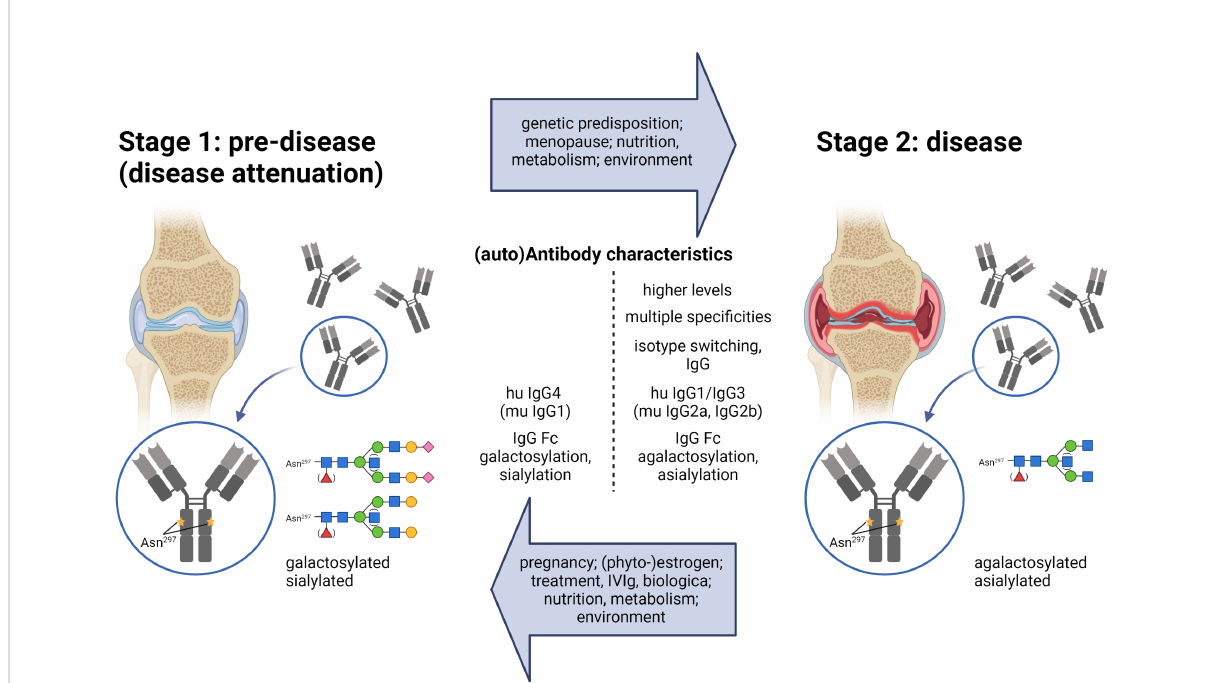
FIGURE 1 The two-stage model for the development of in fl ammatory autoimmune diseases. In Stage 1, the pre-disease state, autoAbs are present, but there are no disease symptoms. Due to reasons indicated in the upper arrow, the condition shifts to an in fl ammatory stage 2, where disease symptoms occur. Enhanced antibody titers, multiple speci fi cities, IgG class switching, and shifts in IgG subclasses and Fc glycosylation patterns are described for autoantibodies in the disease state (described in the text). Factors shown in the lower arrow are con fi rmed, suggested, or discussed to redirect an in fl ammatory antibody response into the direction of the low-/non-in fl ammatory pre-disease state. IgG Fc glycosylation patterns: blue, N -acetylglucosamine (GlcNAcs); green, mannose; red, fucose, yellow, galactose; purple, sialic